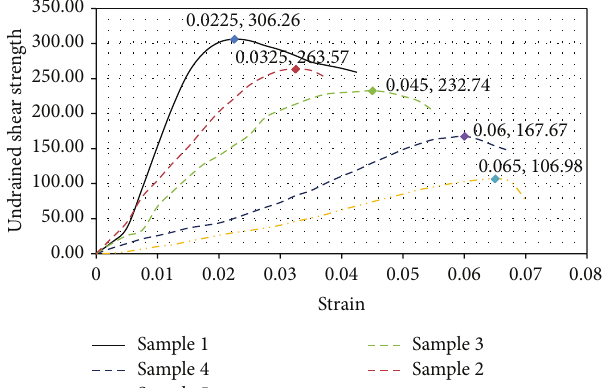
Figure 2: Undrained shear strength in the triaxial compression without measurement of pore pressure, sample 1 to sample 5.